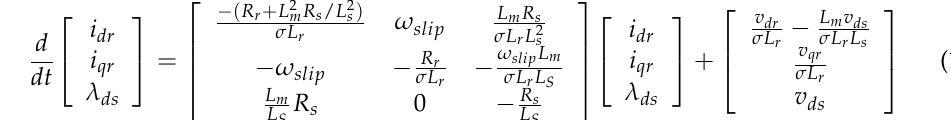
Figure 2. Functional block diagram for real and reactive power control of a doubly fed induction generator (DFIG).